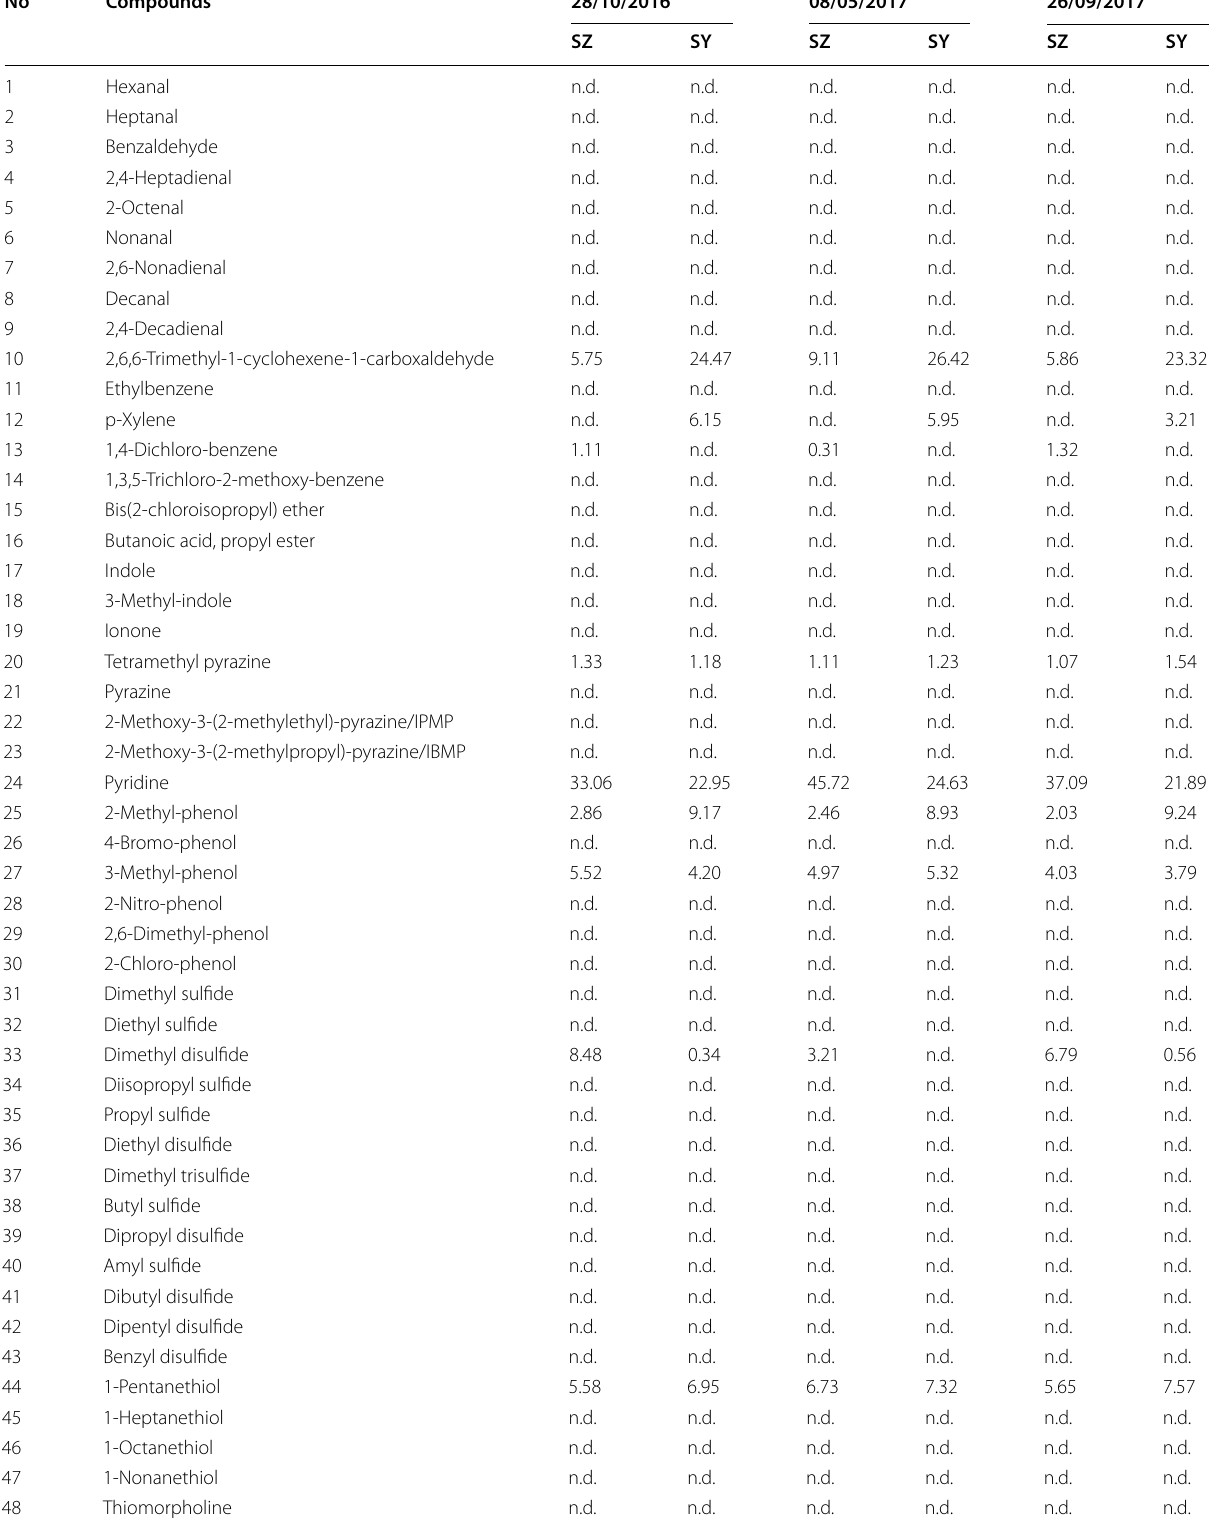
Table 4 GC GC–TOFMS analysis results of two reservoirs × No